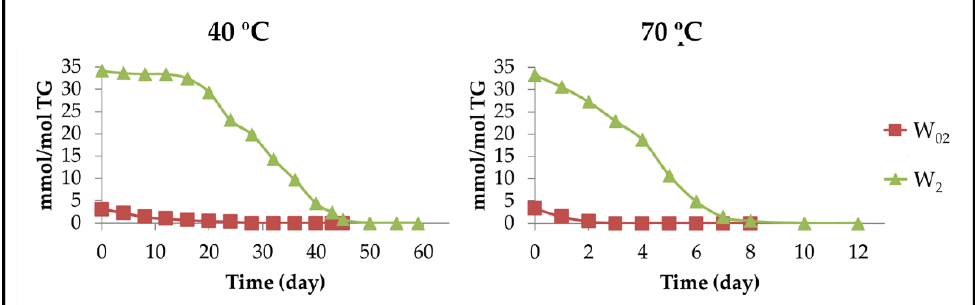
Figure 22. Evolution of the concentration of αT in the several walnut oil samples, initially having two different enrichment levels in αT (W 02 and W 2 ) submitted either to 40 °C or to 70 °C up to advanced stages of the oxidation process.